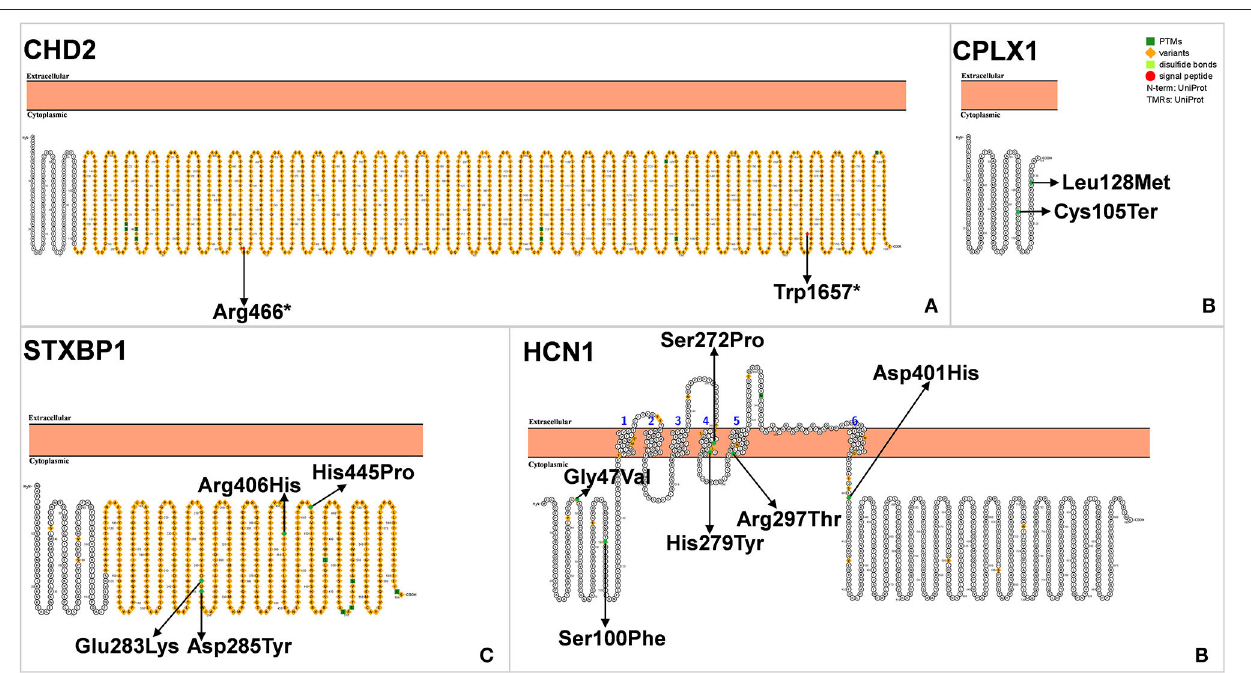
FIGURE 7 | (A–D) Schematic diagram of protein encoded by CHD2, CPLX1, STXBP1, and HCN1A , illustrating the location of the amino acids affected by the mutations identified in